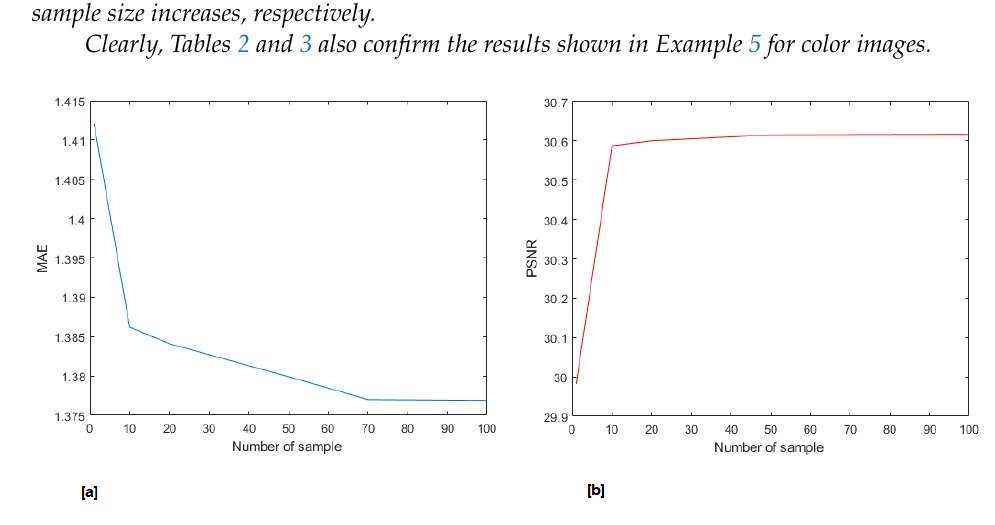
Figure 16. ( a ) MAE of the Baboon image with 10 percent noise. ( b ) PSNR of Baboon image with 10 percent